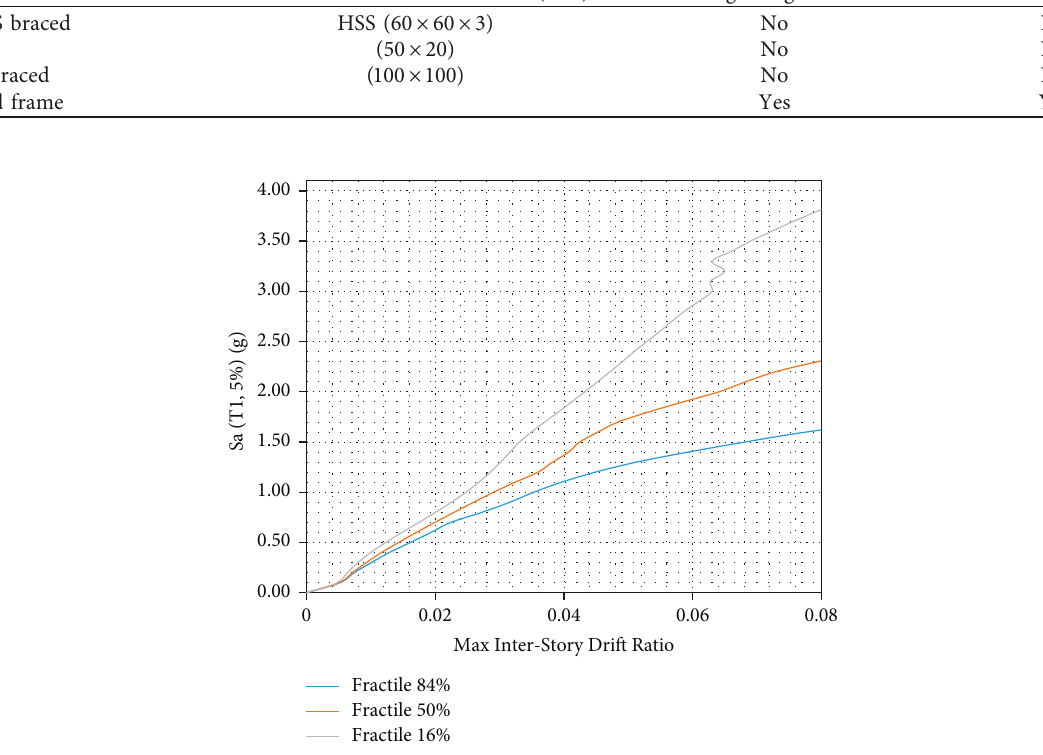
Figure 23: Fractile curves of the unbraced portal